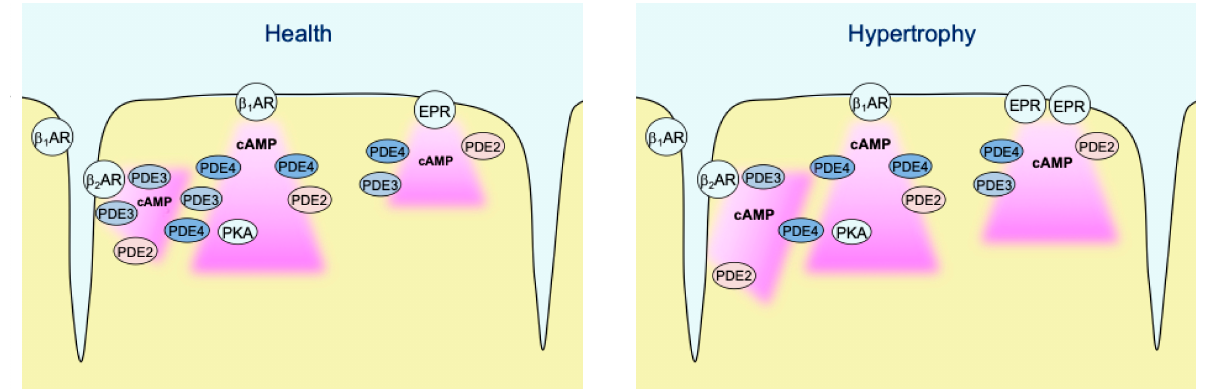
Figure 8. Schematic diagram highlighting the major findings of the study. In healthy AMVMs, cAMP synthesis in non-raft membrane microdomains can be stimulated by β 1 - and β 2 -adrenergic receptors ( β -ARs), as well as by EP2/4 prostaglandin receptors (EPRs). Each pool of cAMP is under control by phosphodiesterases PDE2, PDE3, and PDE4. While all three PDEs are almost equally regulating EP2/4 receptor signals, β 1 -AR/cAMP is under predominant control by PDE4 and β 2 -AR/cAMP is mostly controlled by PDE3. In hypertrophy, PDE3 is redistributed away from β 2 -AR which leads to stronger local cAMP responses. In addition, EP2/4 receptor expression is upregulated after TAC, which leads to stronger cAMP responses to PGE1 even though the relative PDE effects of this pool of cAMP are not changed.